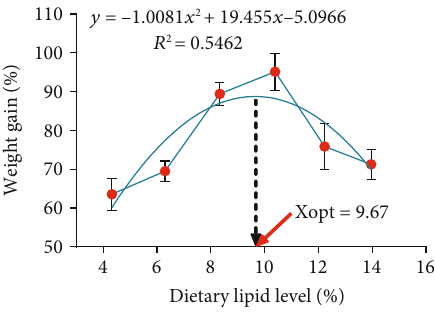
Figure 1: The relationship between weight gain (WG) (%) and the di ff erent dietary lipid levels. Xopt represents the optimal dietary lipid level for the maximum WG of juvenile C. quadricarinatus . Each point in the picture represents the mean value of four replicates.